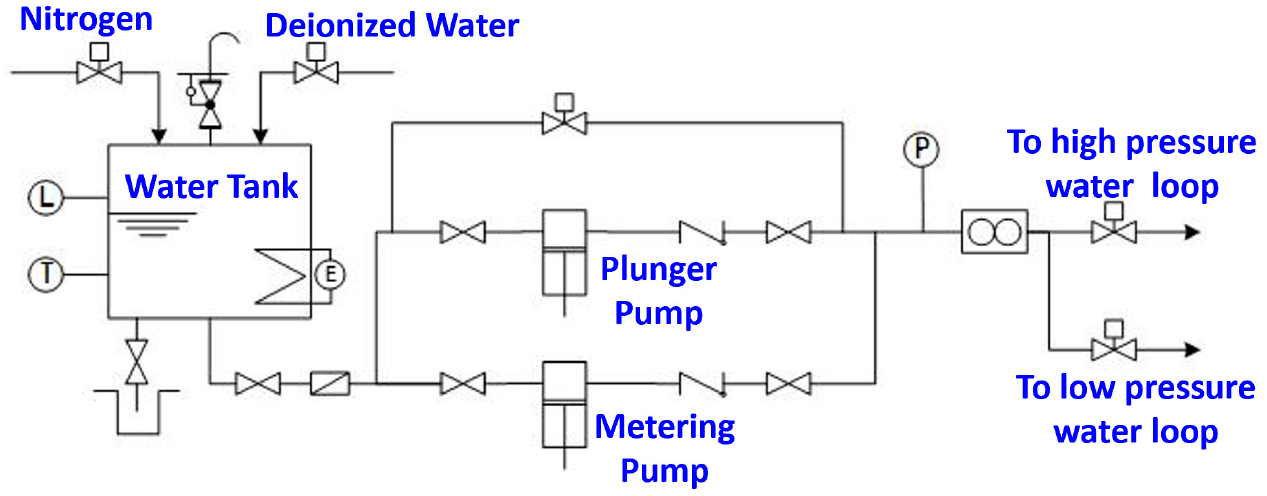
Figure 9. Scheme of the water charging system. Table 6. Design parameters of the water charging system.